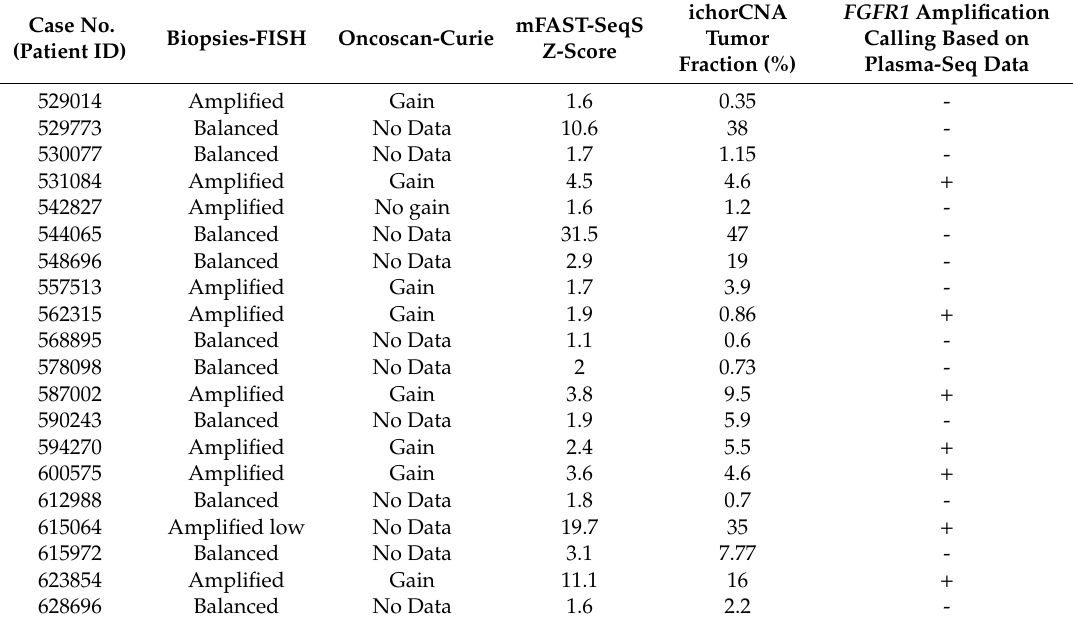
Table 4. Amplification calling based on FISH, Oncoscan testing, and plasma-Seq data. Case